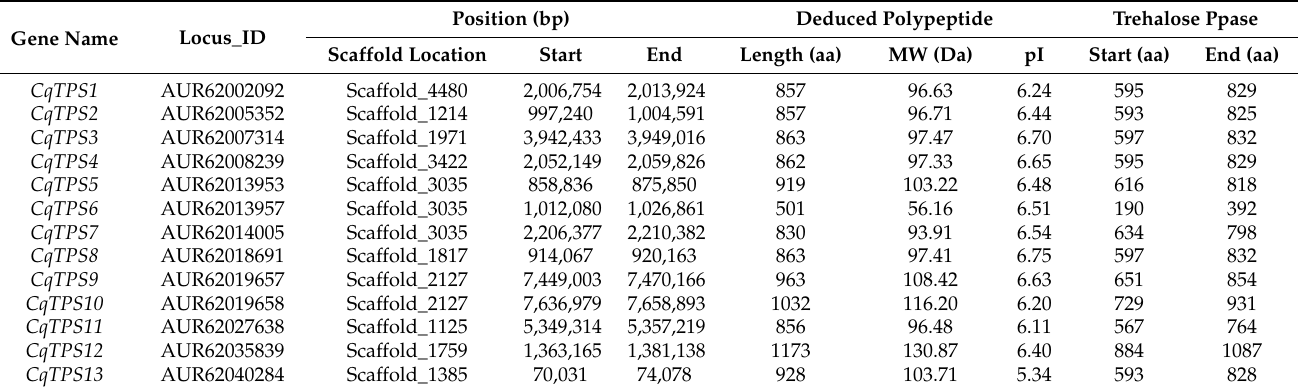
Table 1. Basic information of CqTPS genes in quinoa genome.